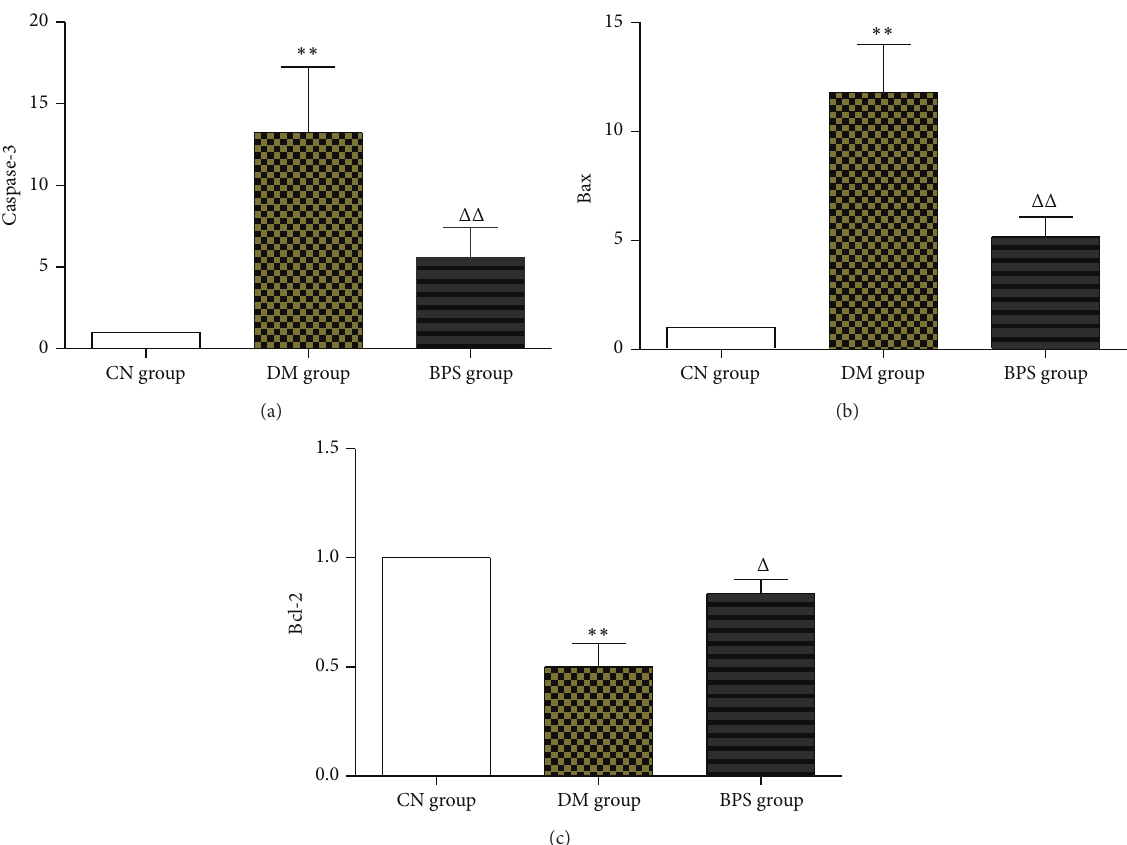
Figure 8: RT-PCR results of apoptosis genes in the myocardial tissues of each group. Compared with the CN group, the expression of caspase- 3 and Bax mRNA significantly increased ( 𝑃 < 0.01 ) and the expression of Bcl-2 mRNA significantly decreased ( 𝑃 < 0.01 ) in the myocardial tissues of rats in the DM group. In the BPS rats, the expression of caspase-3 and Bax mRNA increased, and the expression of Bcl-2 mRNA decreased ( 𝑃 > 0.05 ). Compared with the DM group, the expression of caspase-3 and Bax mRNA significantly decreased and the expression of Bcl-2 mRNA significantly increased in BPS rats ( 𝑃 < 0.05 ).